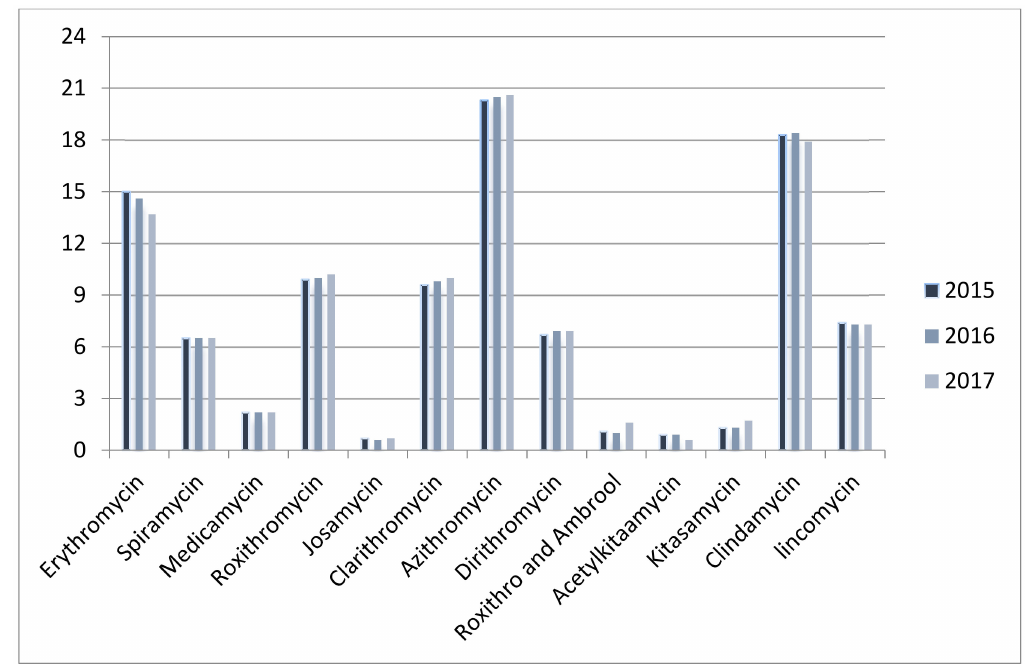
Figure 1. % Changes in the patterns of J01F use in hospital care between 2015 and 2017.